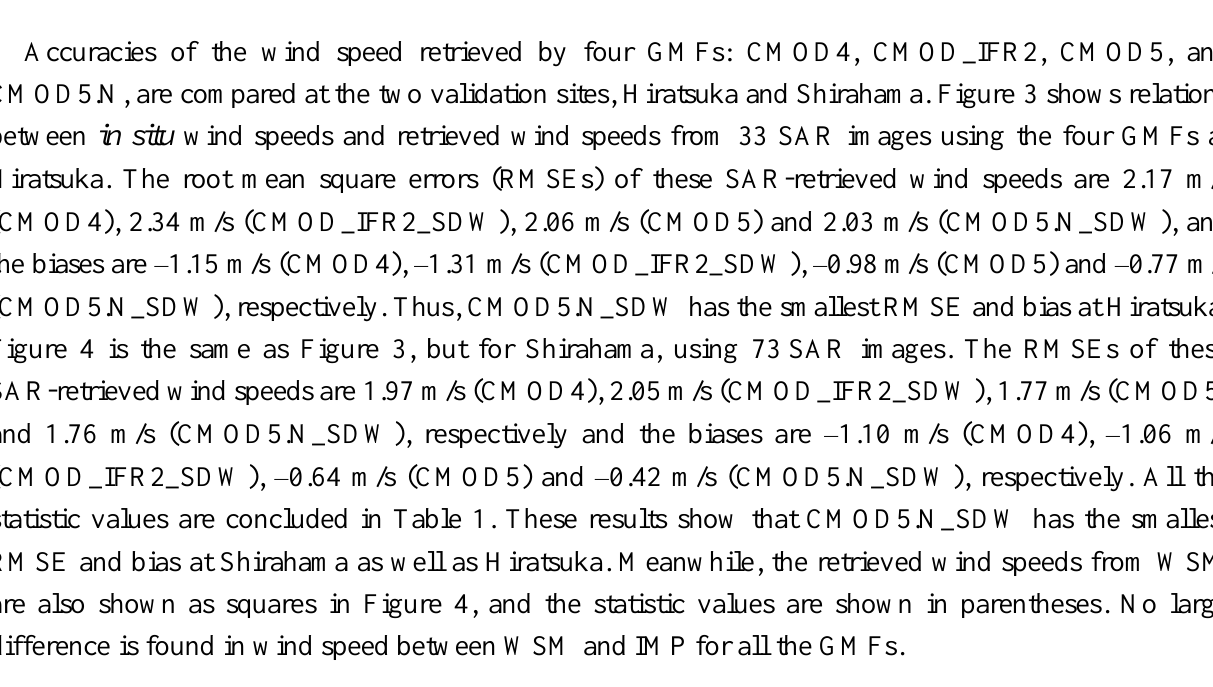
Figure 3. R elations between 33 SAR-retrieved wind speeds and in situ wind speeds